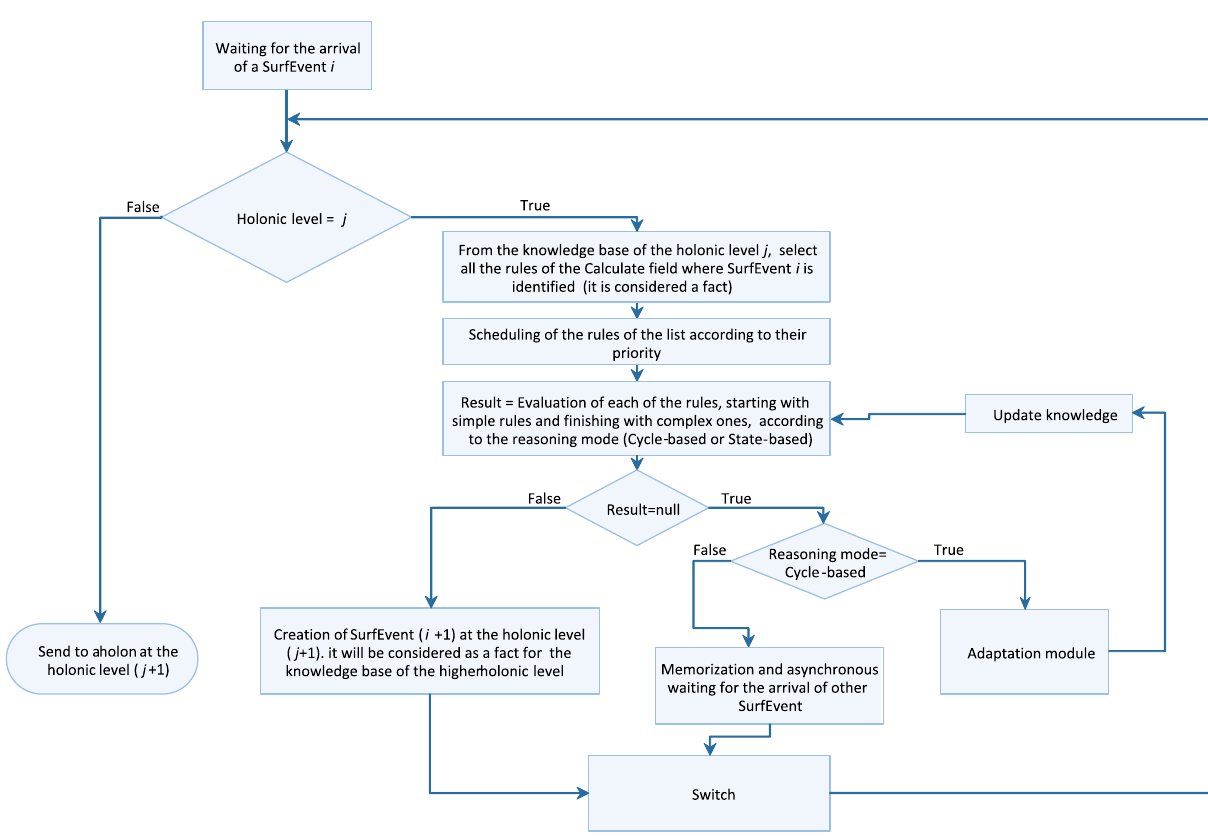
Fig. 12 Algorithmic description of backward